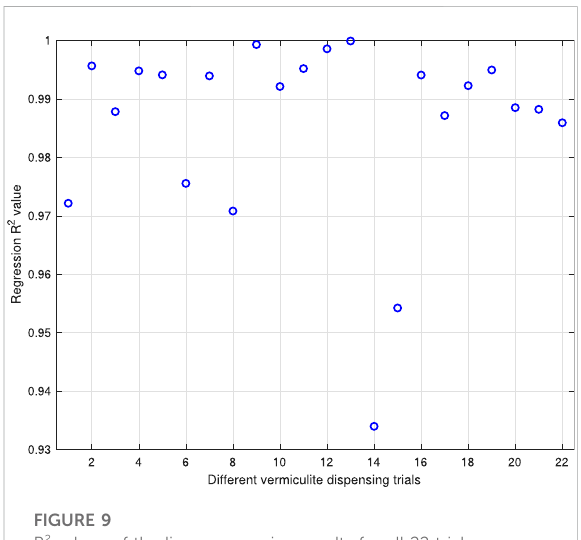
FIGURE 9 R 2 values of the linear regression results for all 22 trials.